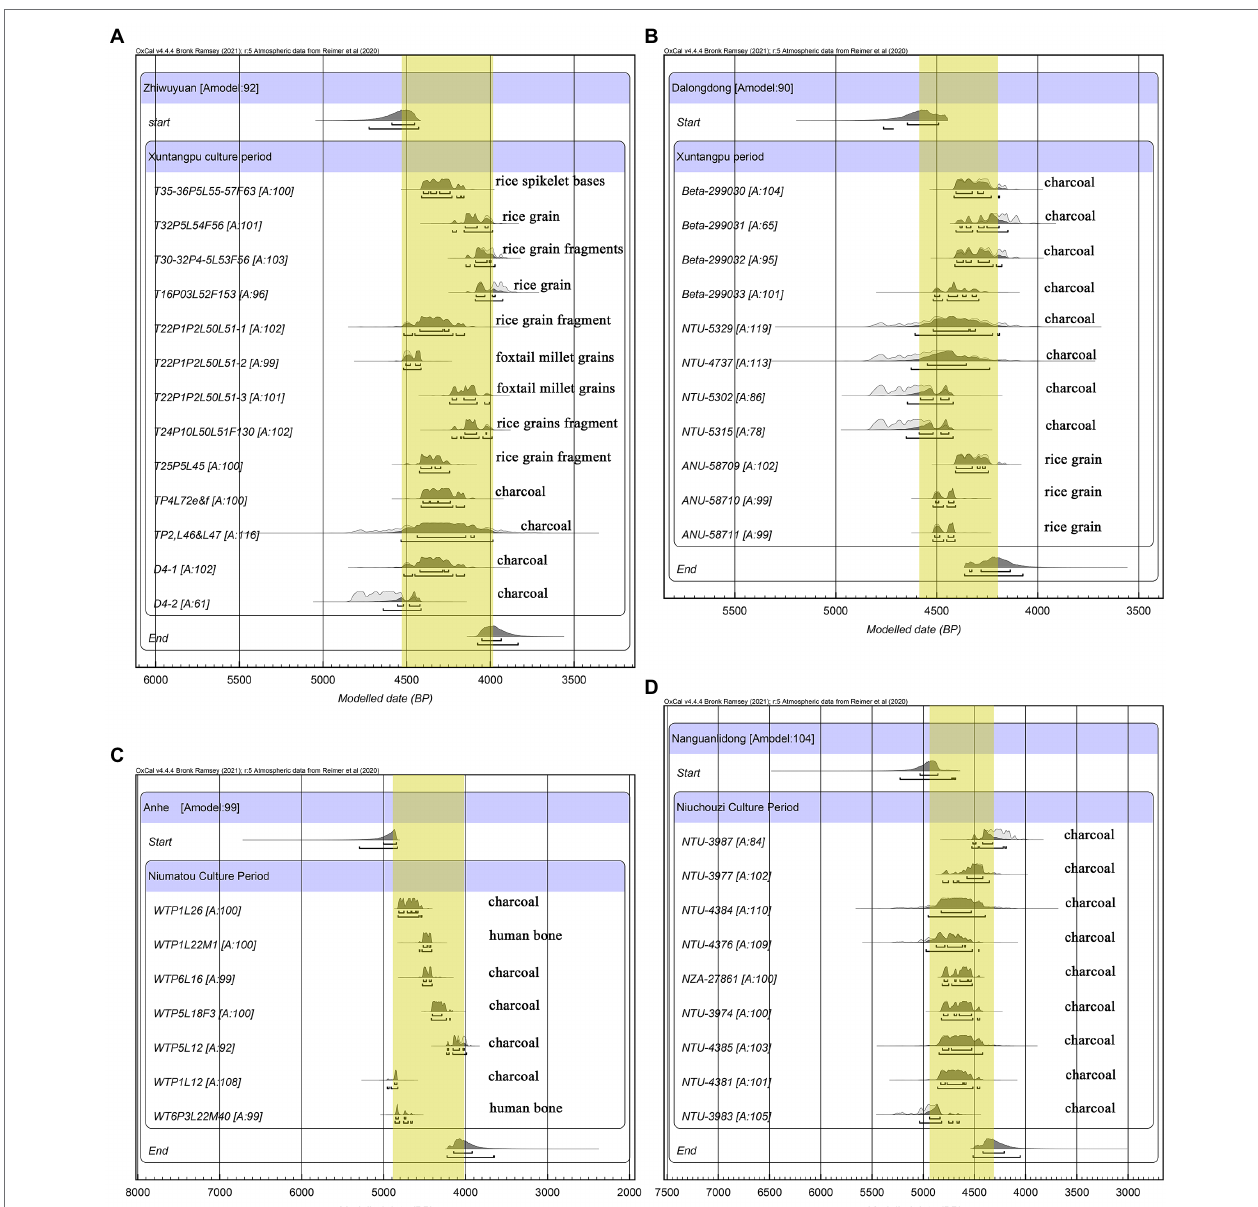
FIGURE 3 | Radiocarbon dates from Zhiwuyuan (A) , Dalongdong (B) , Anhe (C) , and Nanguanlidong (D) , calibrated in a Bayesian model incorporating phasing by OxCal 4.4 (Bronk Ramsey, 2009) using the IntCal20 atmospheric curve (Reimer et al., 2020; References of previous data and details of all data are presented in Supplementary Table S2